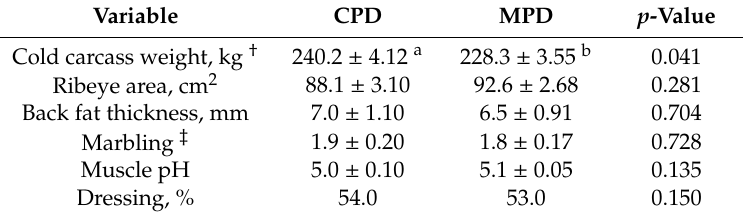
Table 4. Least square means for carcass characteristics variables measured in heifers fed with two di ff erent